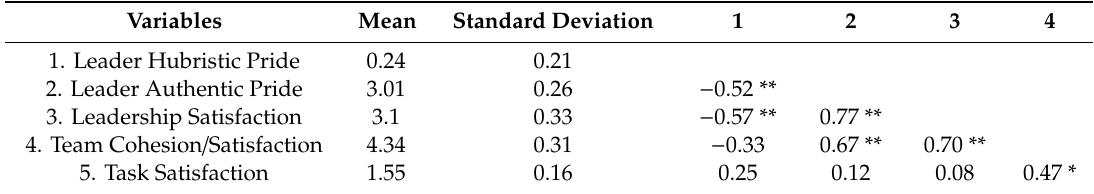
Table 3. Correlation table of group aggregated leader expressed pride and outcome variables ( N = 22).